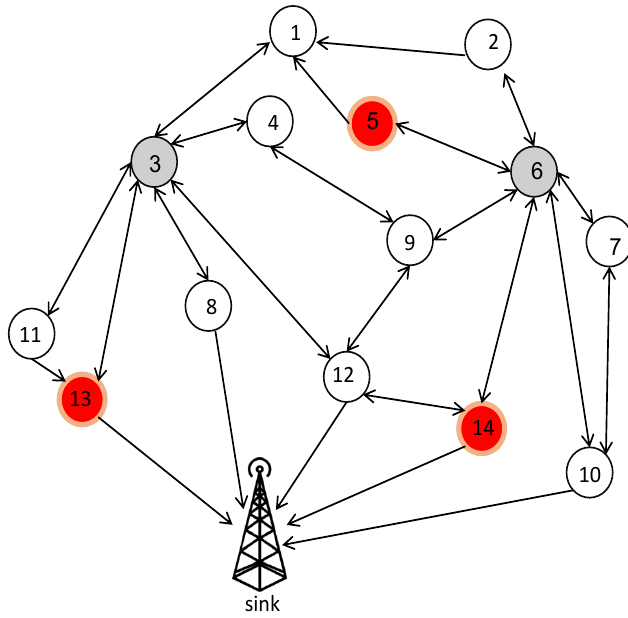
Figure 4. A random deployment of 15 nodes with two cluster heads of CH 3 and CH